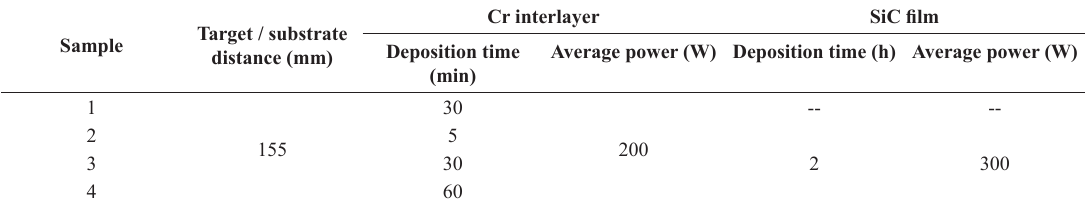
Table 1. Deposition